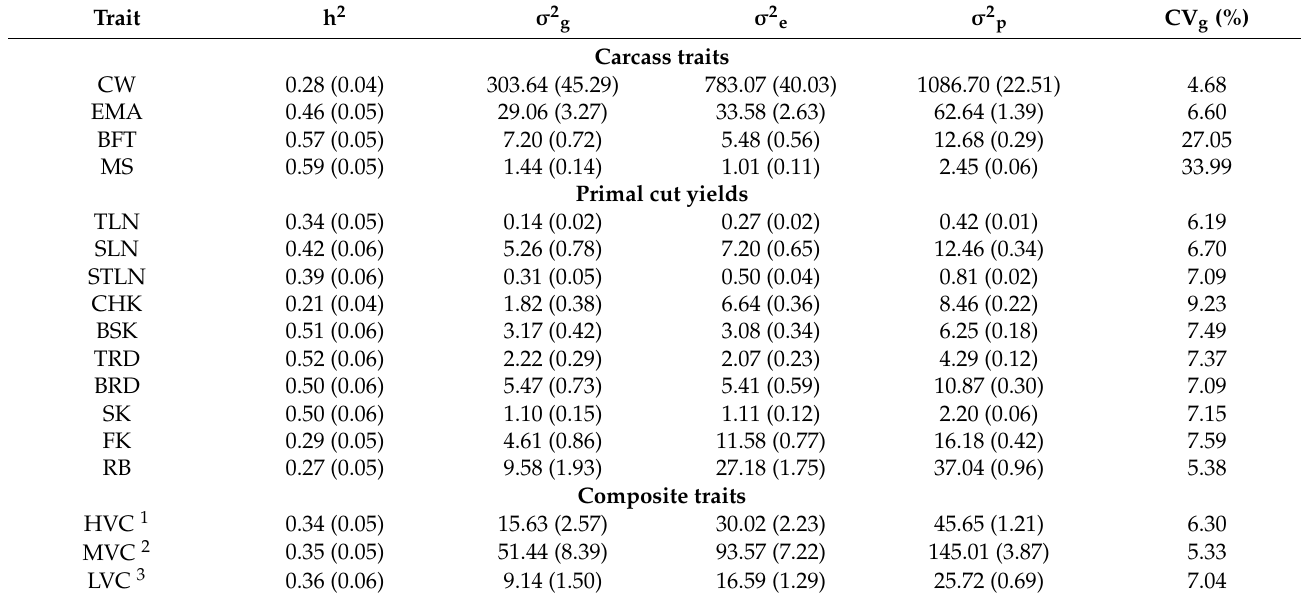
Table 2. Estimates of heritability (h 2 ), additive genetic variance ( σ 2 g ), residual variance ( σ 2 e ), and coefficient of genetic variation (CV g ) for carcass traits, primal cut yields, and composite traits in Hanwoo cattle.